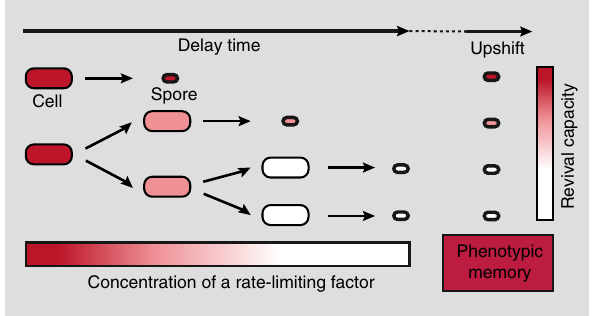
Fig. 7 Intrinsic spore memory model. A factor X (red) limits spore revival and its production ceases during starvation. As cells delay sporulation, the concentration of X decreases due to dilution/degradation. Thus, less of X is available for carry-over into spores, resulting in spores with decreasing levels of X and differential revival capacities